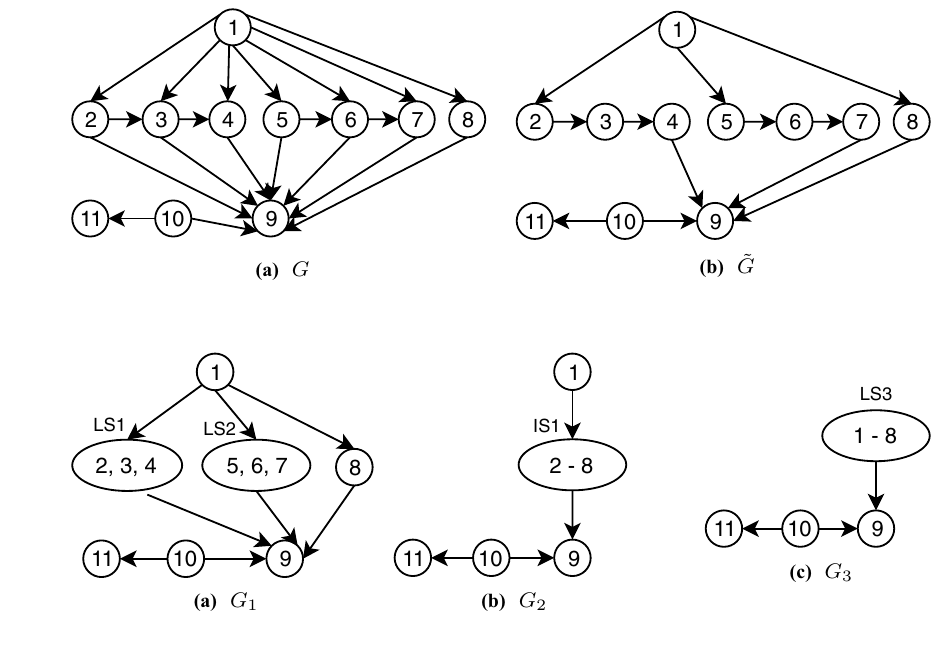
Fig. 4 a Graph G 1 after first- level compression, b graph G 2 after second-level compres- sion and c graph G 3 after final compression. LS denotes linear module, and IS denotes